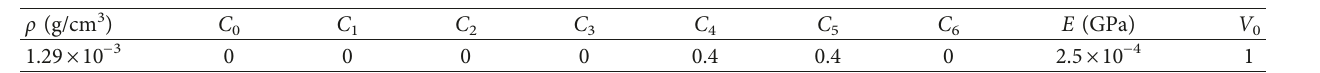
Table 4: Material parameters of air [25].